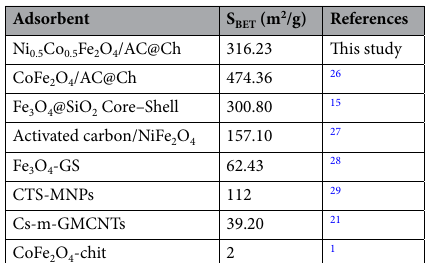
Table 1. Comparison of the adsorbents surface area (S BET ) in pervious literature and the present study.